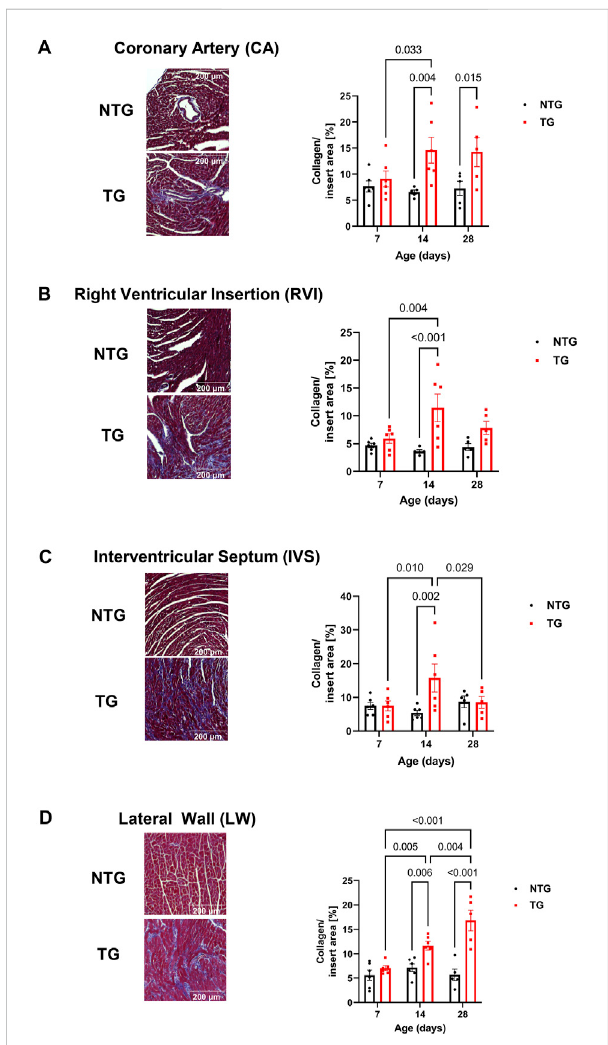
FIGURE 6 Time-dependent assessment of localized fi